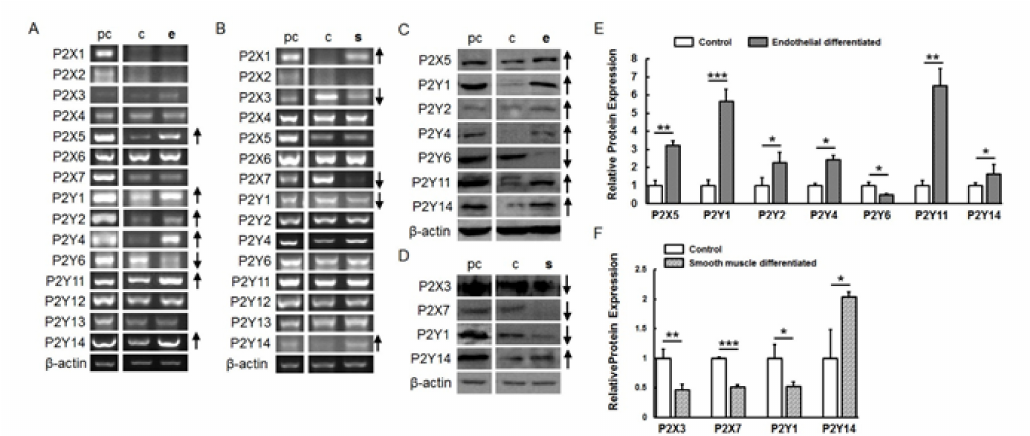
Figure 3. Regulation of P2 receptor expression after endothelial and smooth muscle cell di ff erentiation. P2 receptor gene expression after endothelial ( A ) and smooth muscle di ff erentiation ( B ). P2 receptor protein expression after endothelial ( C ) and smooth muscle di ff erentiation ( D ) by Western blot with β -actin as the internal control. Graphs ( E , F ) represent the quantification of bands normalized with β -actin in undi ff erentiated and di ff erentiated cells. pc, positive control; c, un-di ff erentiated cells; e, endothelial di ff erentiated cells; s, smooth muscle di ff erentiated cells. ↑ indicates an up-regulation of the P2 receptor subtype during di ff erentiation, and ↓ indicates a down-regulation. The data shown represent 1 donor out of 3). (* p < 0.05; ** p < 0.01; *** p < 0.001).